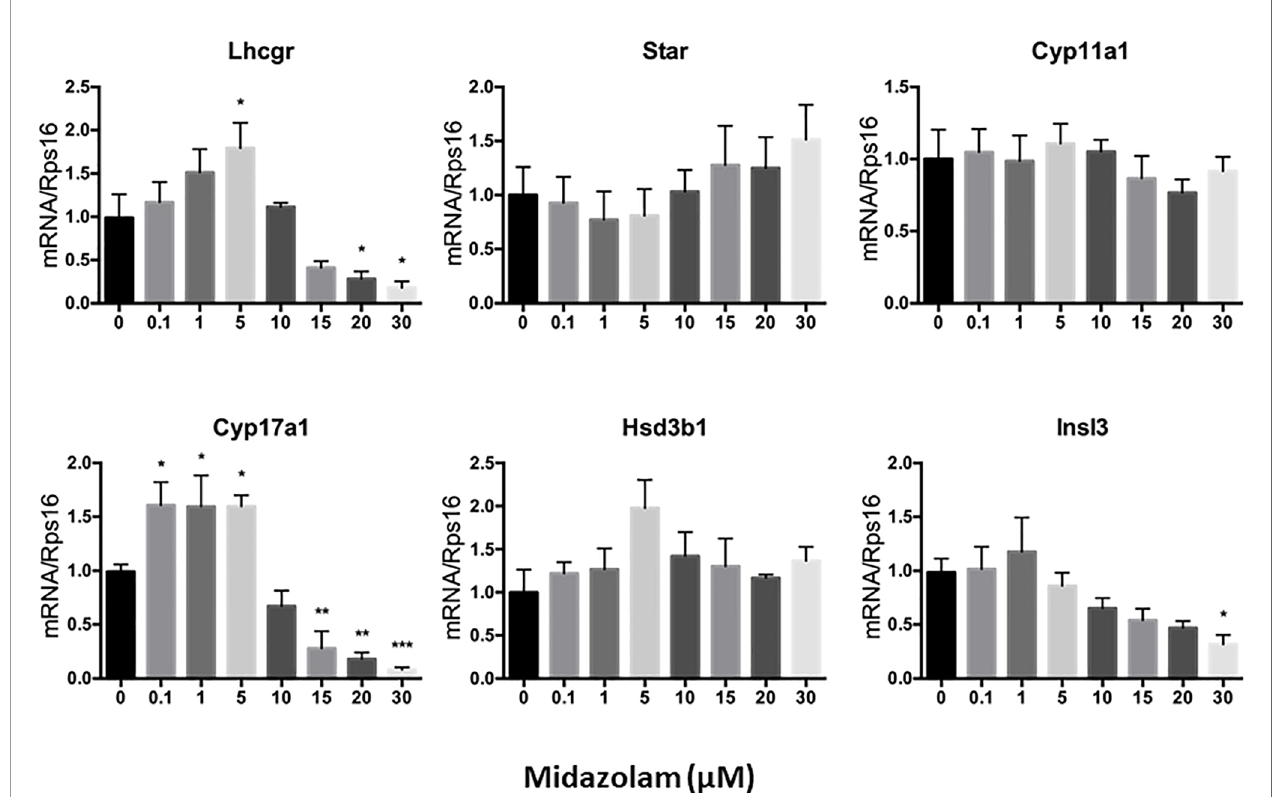
FIGURE 5 | Effects of midazolam on the expression of steroidogenic genes: stem Leydig cells were induced to differentiate into Leydig cells in the presence of different concentrations of midazolam for 21 days. Expressions of steroidogenic genes were assayed by QPCR with Rps16 as an internal control. Data are expressed as mean ± SEM of fi ve experiments. Signi fi cantly different from the control groups at *p < 0.05, **0.01, or